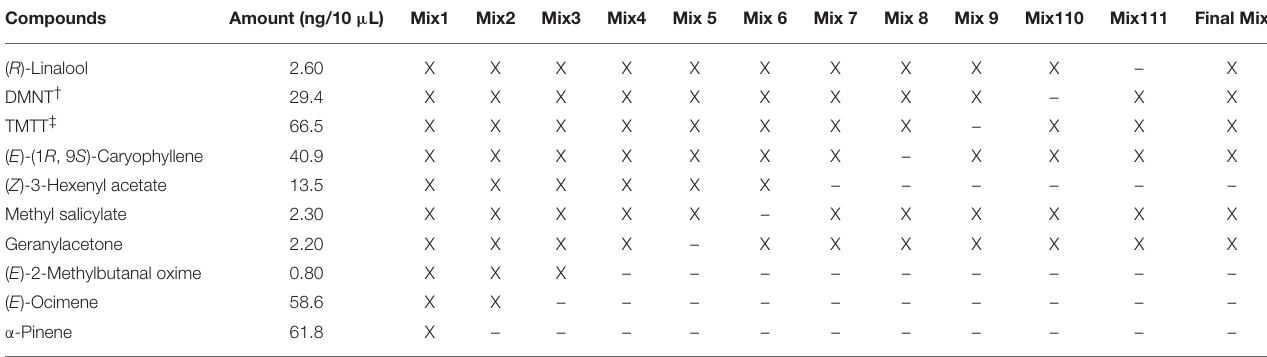
TABLE 1 | Components of the synthetic volatile blends comprising of the electrophysiologically active compounds for Anthonomus grandis . Compounds